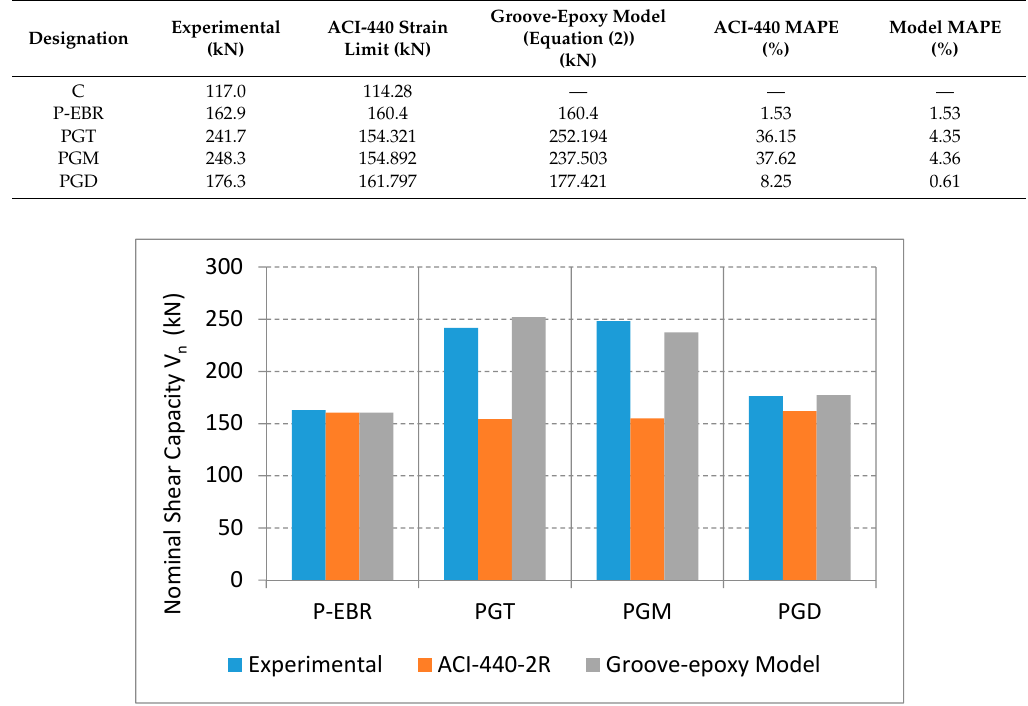
Table 5. Measured and predicted loads for RC beam strengthened with CFRP plates on groove-epoxy.